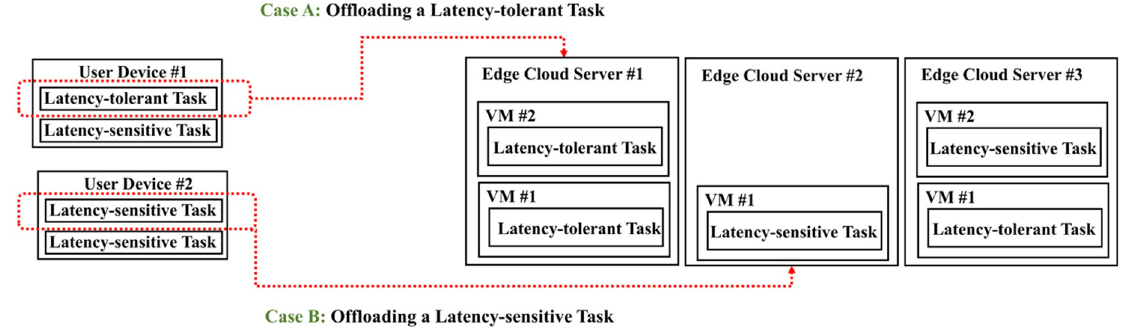
Figure 2. An illustrative example of the LCDA (latency classification based deadline aware task offloading algorithm).